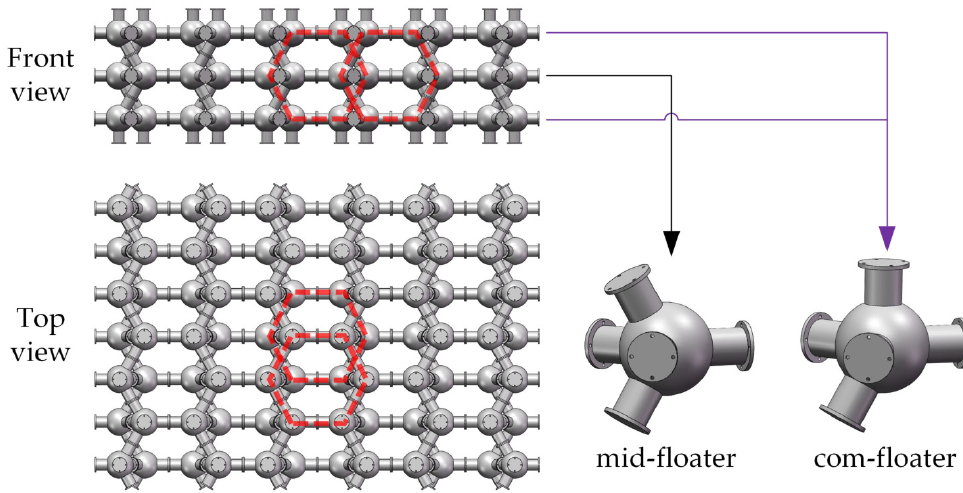
Figure 2. Sketch of the BDFF consisting of mid-floaters and